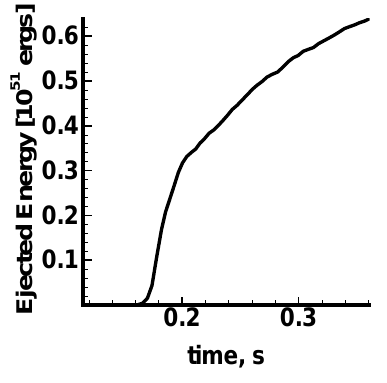
Figure 5: Time dependence of the ejected energy dur- ing the magnetorotational explosion with initial dipole magnetic field, from